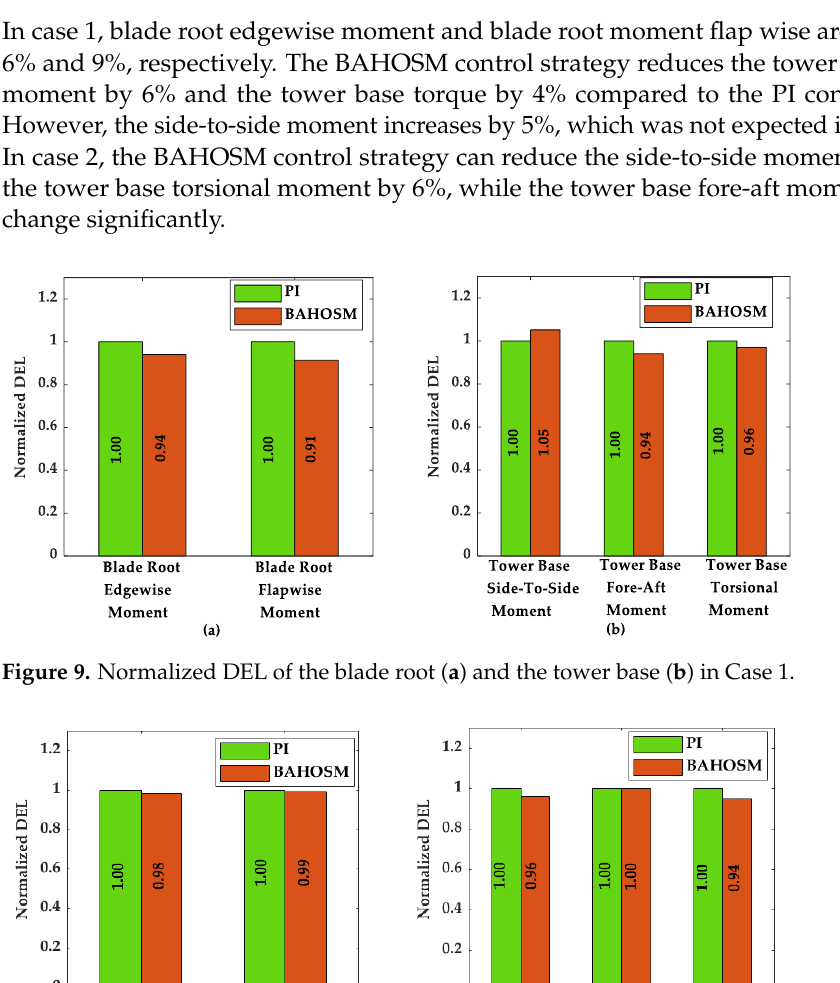
15 of 20 Figure 8. RMS of the platform motion in case 1 ( a ) and case 2 ( b ).